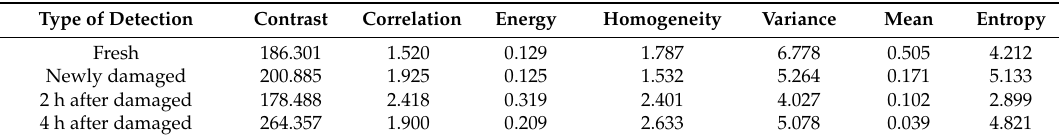
Table 3. Averaged textural features extracted by GLCM.